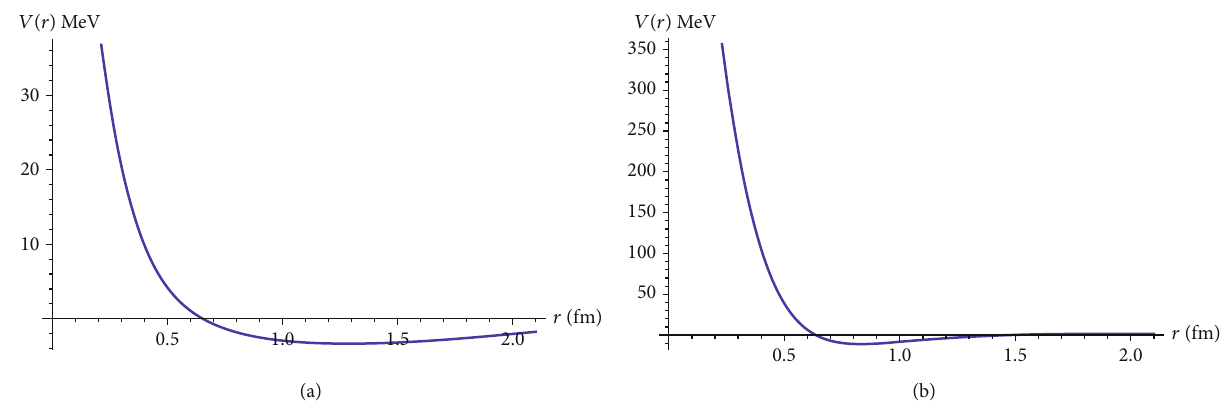
Figure 3: The potential with GY and SPED functions, respectively, of 2 H nuclei as OBEP through the exchange of σ and ω mesons, with parameter II.